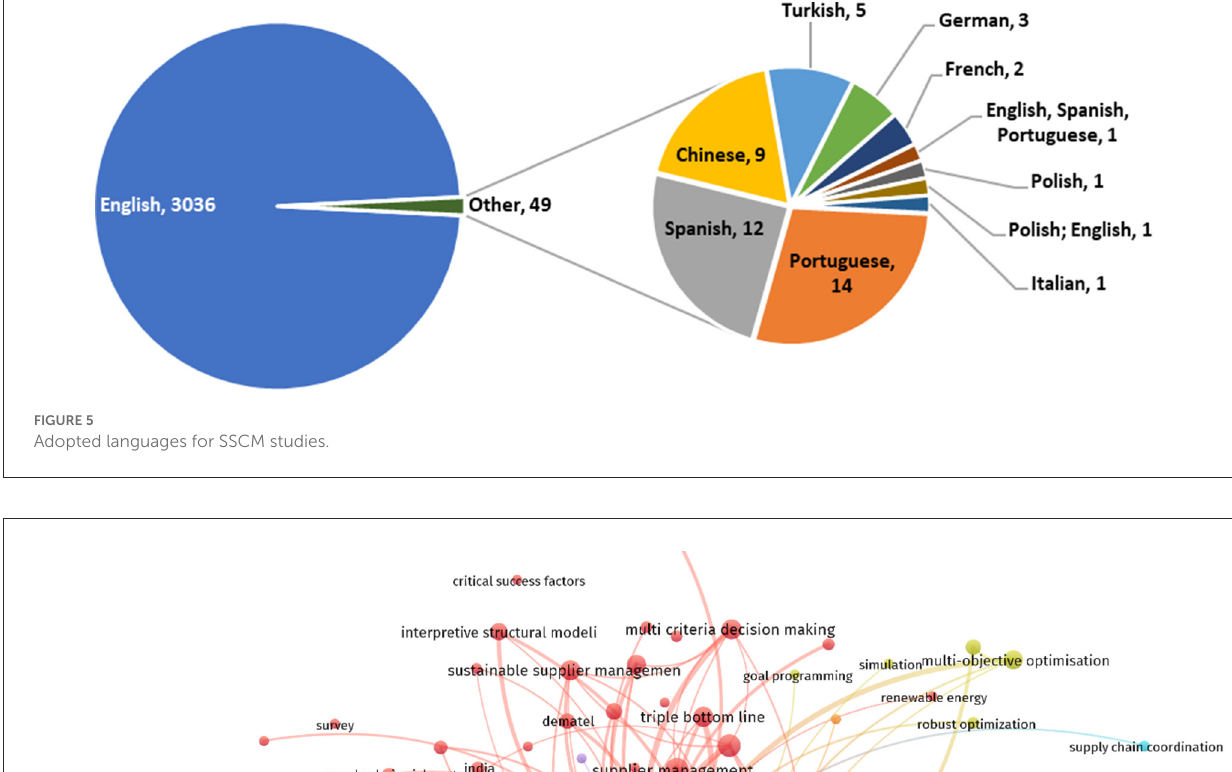
In total, 7,265 different keywords were found from the 3,085 articles; however, 178 keywords were highlighted as having been mentioned at least 10 times and having some connections with other keywords (Figure